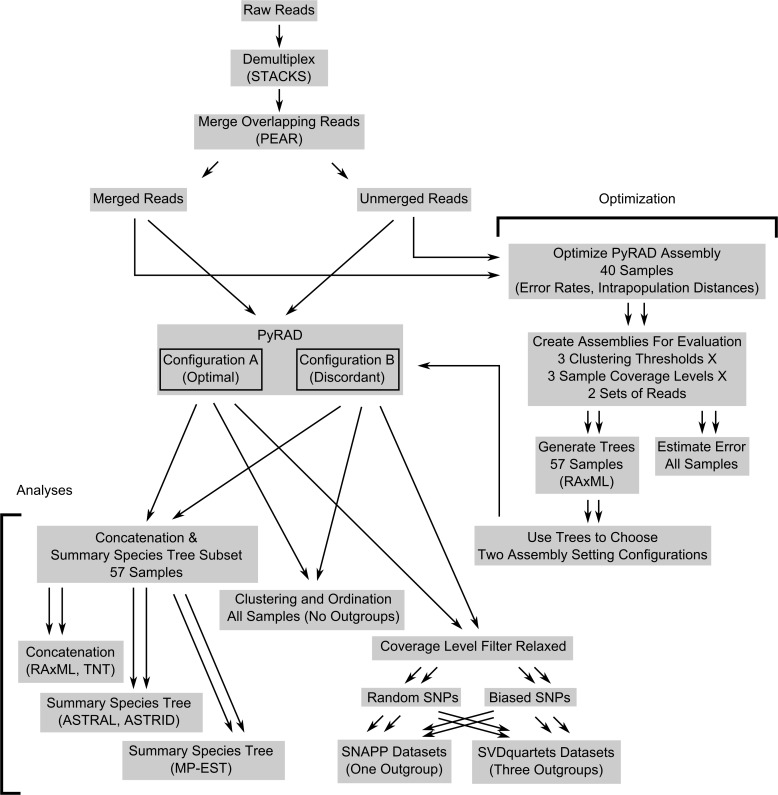
Schematic of bioinformatic and analytical steps presented in this study.